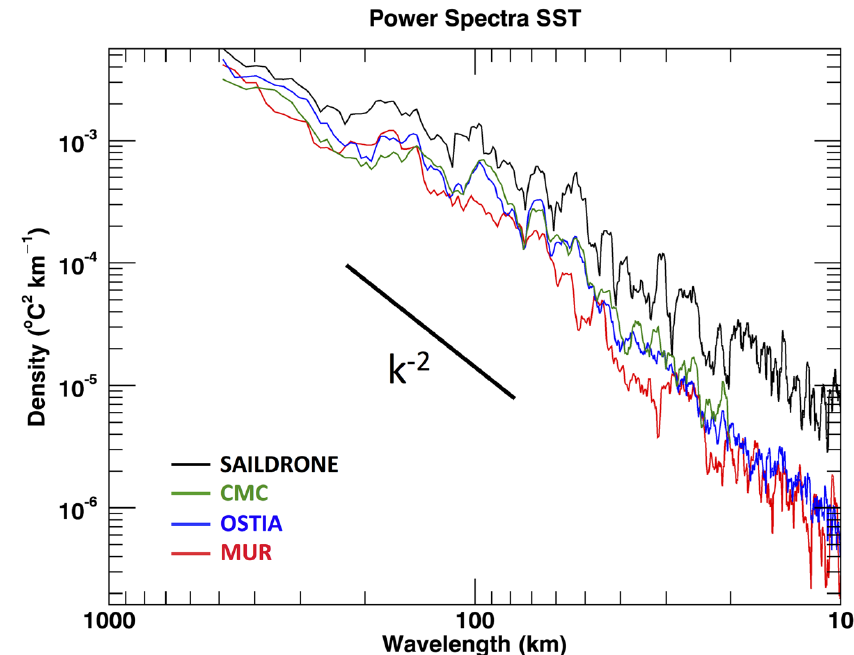
Figure 7. Power spectra for the three satellite-derived SST products and Saildrone SST. For the